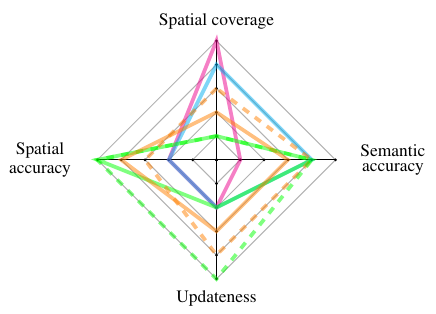
Figure 1. Categorization and evaluation of the four main groups of land-cover products, with respect to four main features: global, continental, national,